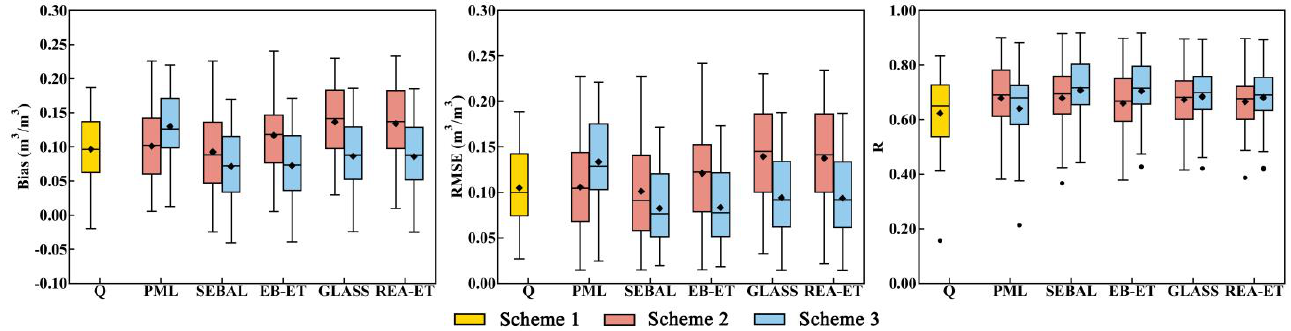
Figure 10. Statistics of model performance for the VIC soil moisture estimates at 28 soil moisture stations. The optimal values of three metrics are bias = 0, RMSE = 0 and R = 1.